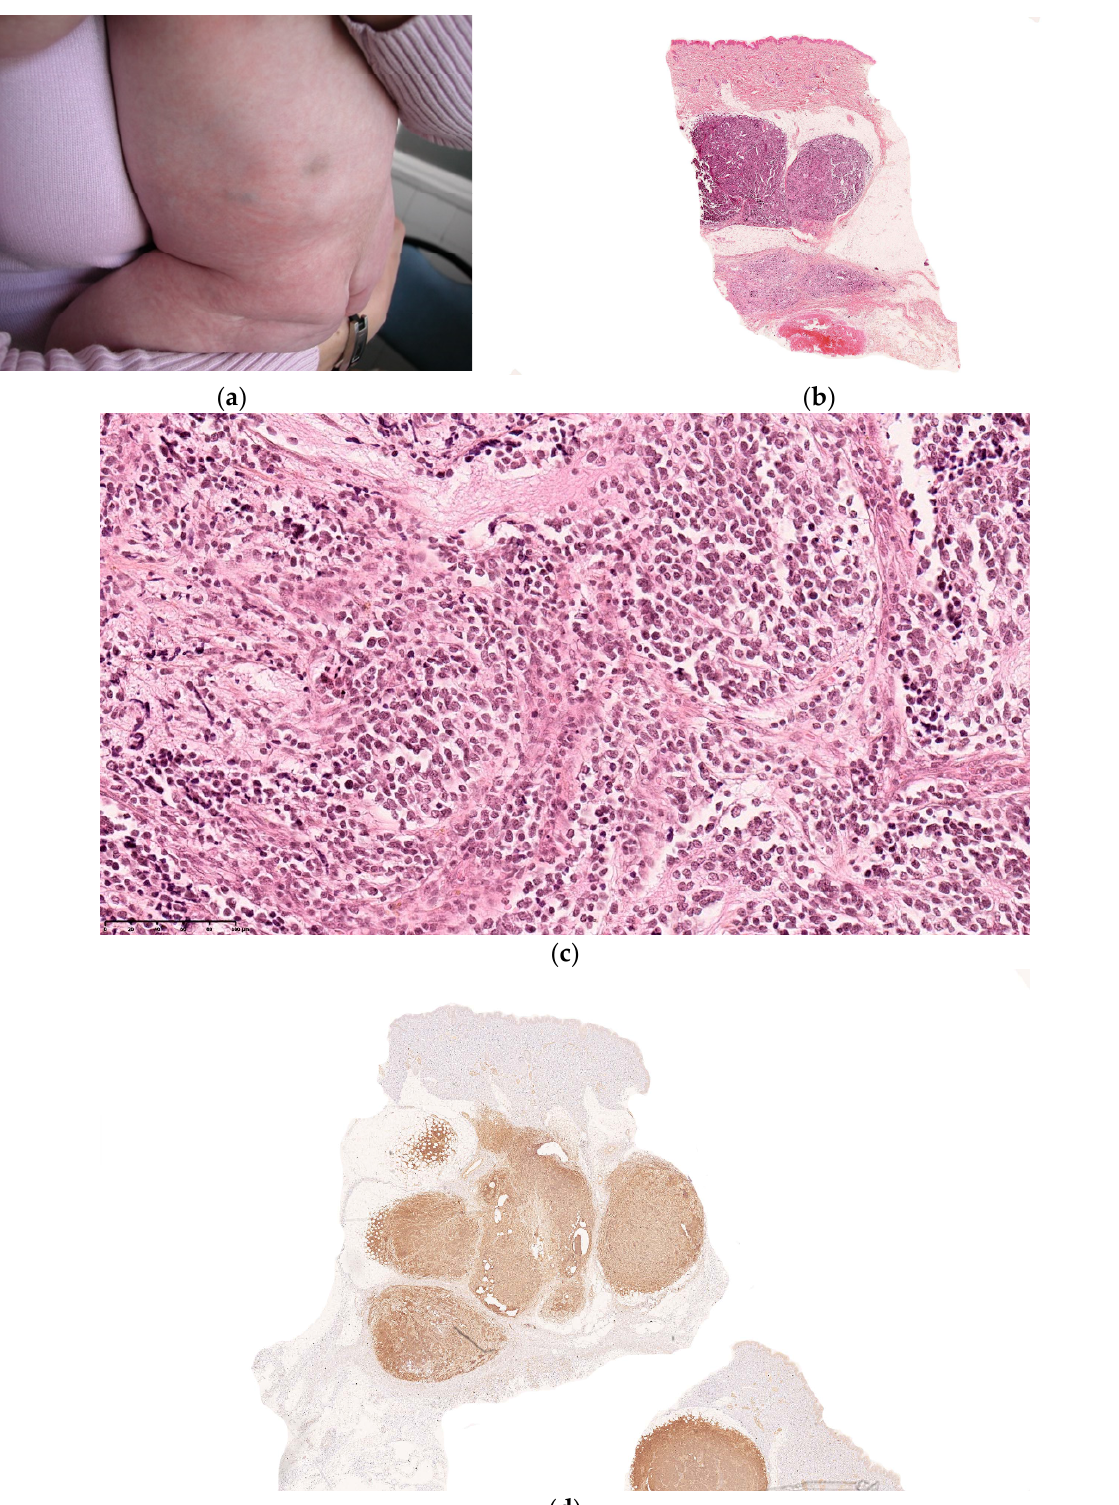
Figure 5. Metastatic neuroblastoma. ( a ) Pink lesion surrounded by a whitish halo. ( b ) 2.5× tumoral nodules in the reticular dermis and the subcutis. ( c ) 25× blue round cells. ( d ) Anti-synaptophysin immunostaining.